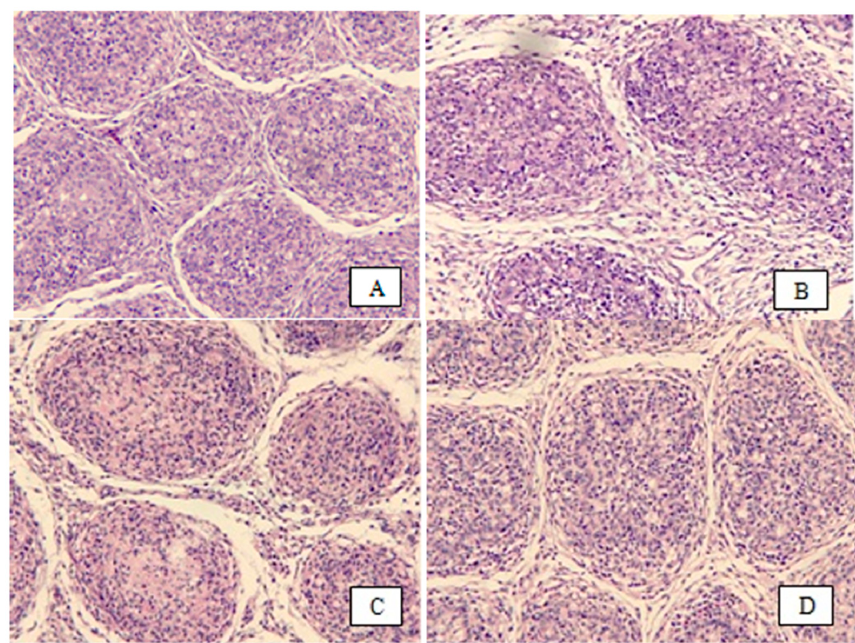
Figure 1. Normal bursal tissue section stained with hematoxylin and eosin (H&E) in the non-infected group.